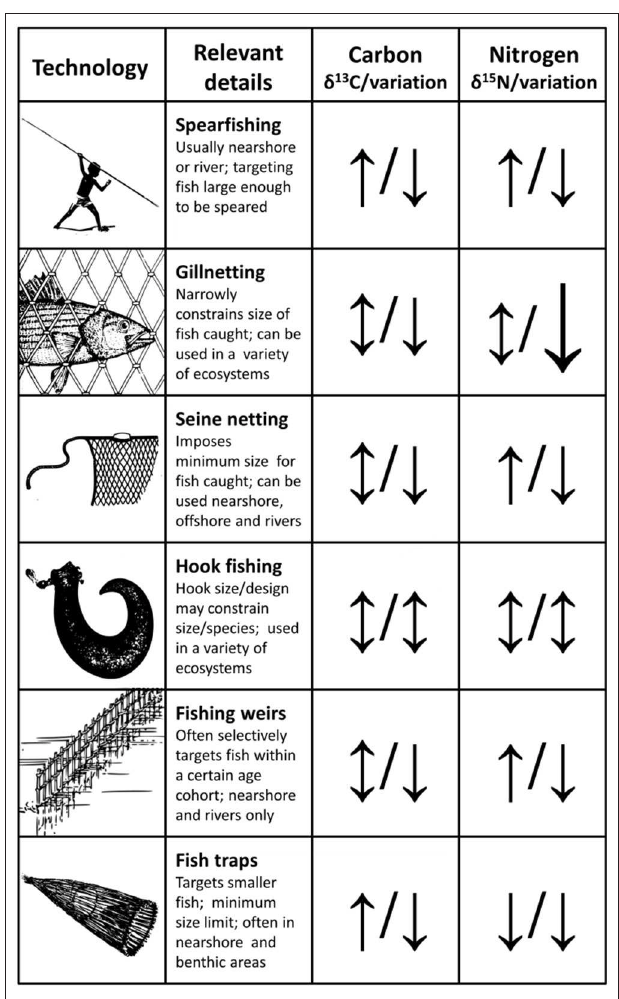
FIGURE 10 | Examples of freshwater fishing technologies and implications of their use for the isotopic compositions of fish caught. These are generalizations and, in all cases, the direction and intensity of trends will vary based on a wide range of contextual variables including where, when, and how technologies were deployed as well as whether a particular species or age cohort was